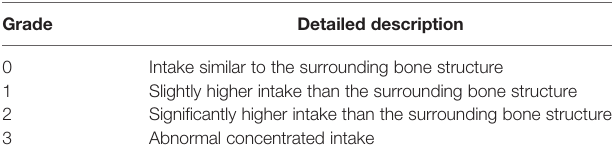
TABLE 1 | The 4-point grade system for scoring the intake degree of bone